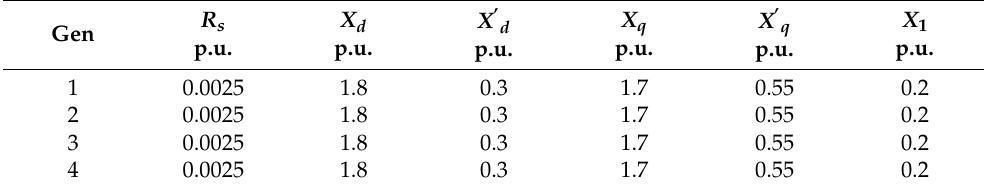
Table A2. Nominal parameters of synchronous generators of a two-zone system.